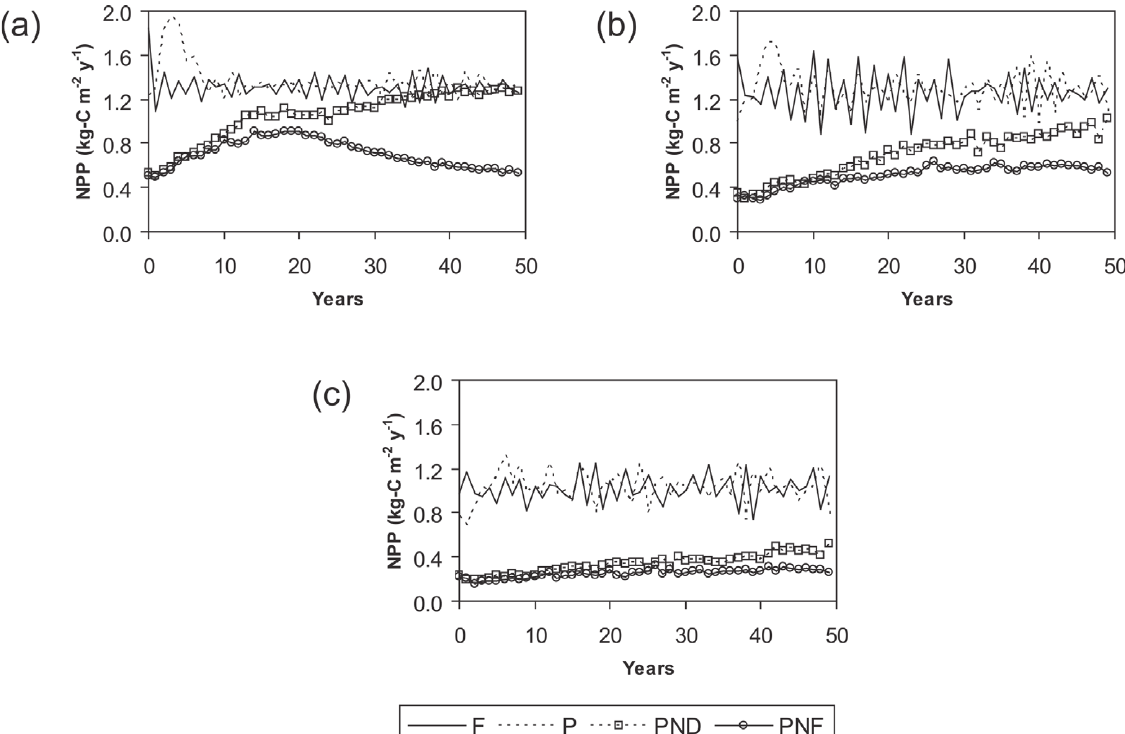
Fig. 3 - The simulated annual mean net primary production for (a) region 1 - Colombia and northwestern state of Amazonas, (b) region 2 - central Amazonia above 10° S, and (c) region 3 - northern state of Mato